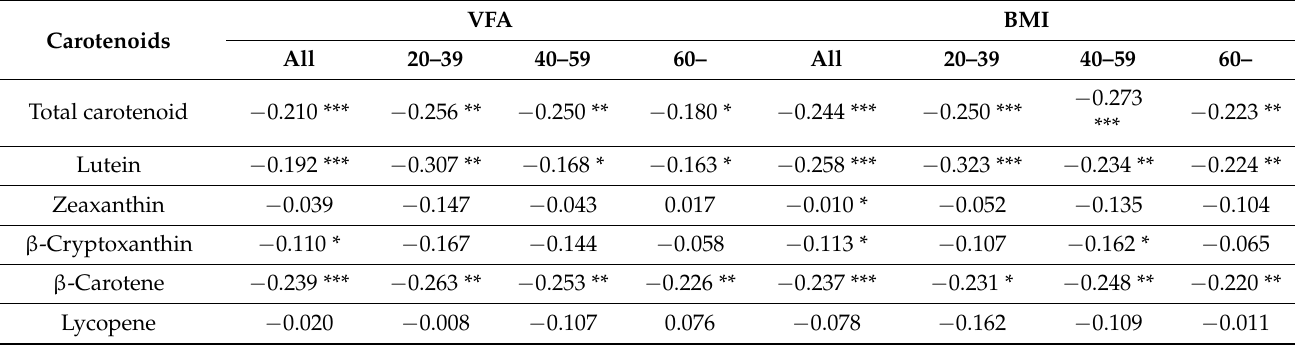
Table 4. Adjusted standard partial regression coefficient between visceral fat area (VFA) or body-mass index (BMI) and carotenoids